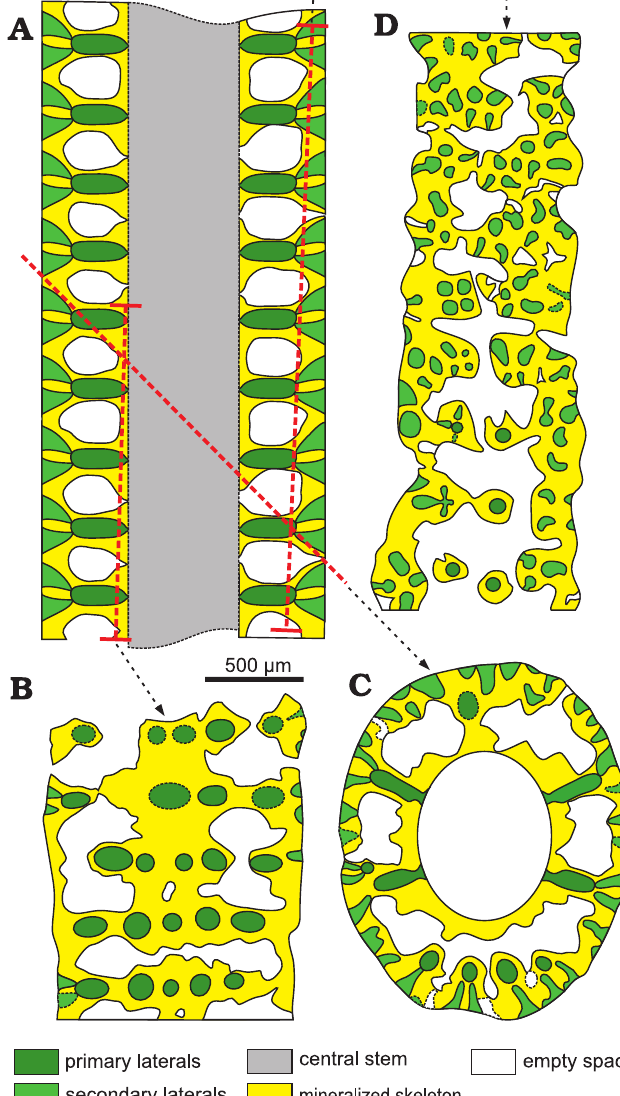
Fig. 13. Interpretation of voids and pores in the sterile specimens of dasycladalean alga Chinianella ellenbergeri (Lebouché and Lemoine in Granier and Deloffre, 1994) Granier, Masse, and Berthou, 1994, emend. nov.; the meaning of the colors are the same as in Fig. 5. A . Axial view (general axial section). B . Proximal tangential section, first and second in- terverticillar spaces from the top are lacking pores, based on specimen in Fig. 9I, LM-DiSTAR /BA.577.37, n. 135, upper part. C . Oblique section, the proximal sleeve is missing interverticillar pores; based on specimen in Fig. 8E, LM-DiSTAR/BA.577.27, n. 124. D . Distal tangential section; note the interverticillar, irregular voids; based on specimen in Fig. 7K, LM- DiSTAR/BA.577.34, n. 132, middle–upper part.